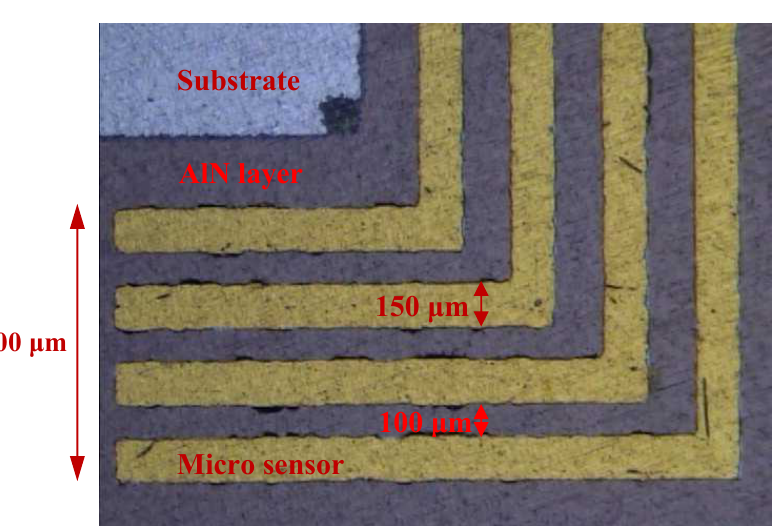
Figure 6. Micro sensors at the under-the-channel area.